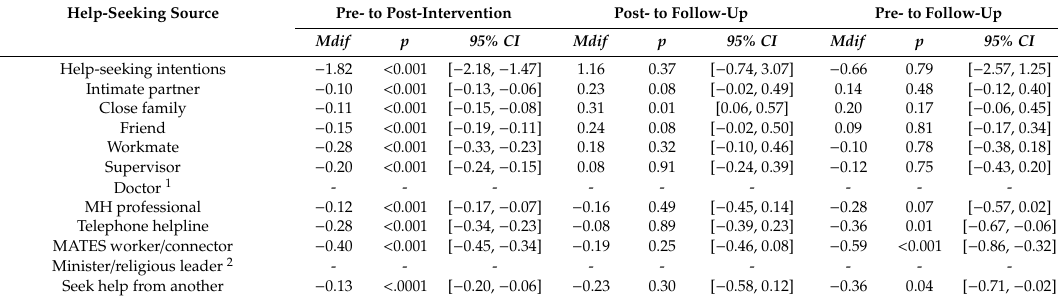
Table 4. Linear mixed model post-hoc analyses on time for help-seeking intention.